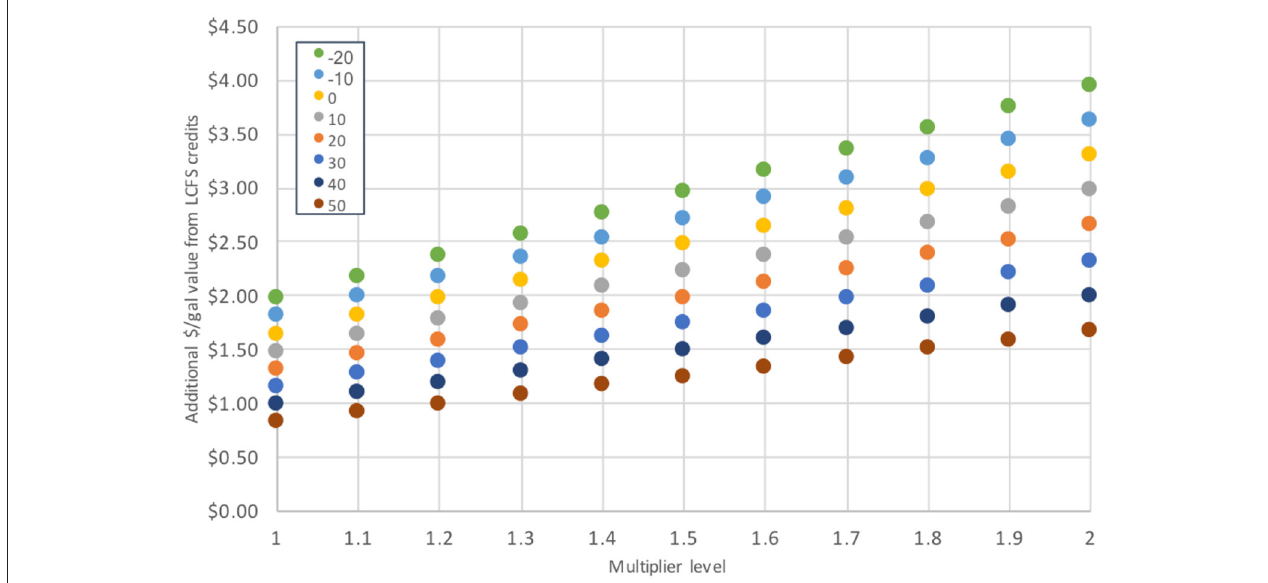
FIGURE 3 | Value of LCFS credits for delivery of a gallon of fuel as a function of that fuel’s CI and the multiplier level applied to that fuel type. We assume a fuel energy content of 81.51 MJ/gal LHV, a LCFS credit price of $200/tCO 2 e, and displacement of California Reformulated Gasoline Blendstock for Oxygenate Blending (CARBOB) with CI = 101.69 MJ/gal